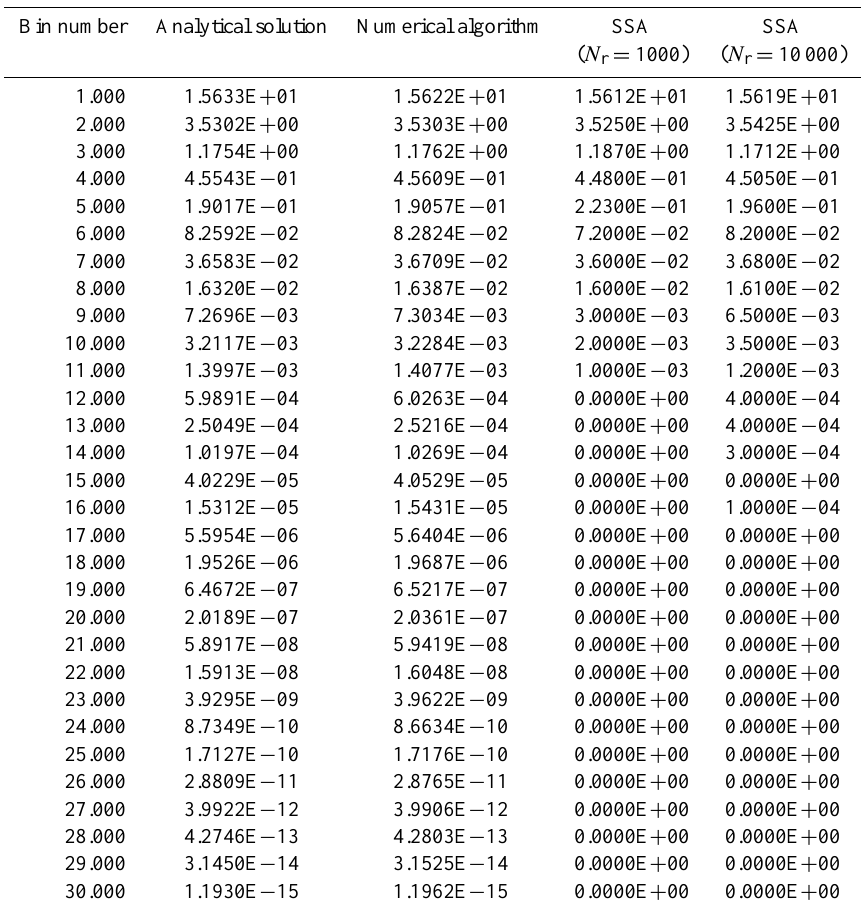
Table 3. Expected values for each droplet mass obtained at t = 1200s for the analytical solution, the numerical algorithm pro- posed in this work, and Gillespie’s SSA (for N r = 1000, 10000 realizations). Calculations were performed with the initial condition P( 30 , 0 , 0 , 0 ,..., 0 ; 0 ) = 1, and the sum kernel K(i,j) = B(x i + x j ) with B = 8 . 82 × 10 2 cm 3 g − 1 s − 1 . Expected values for each droplet size: < n i > , t =